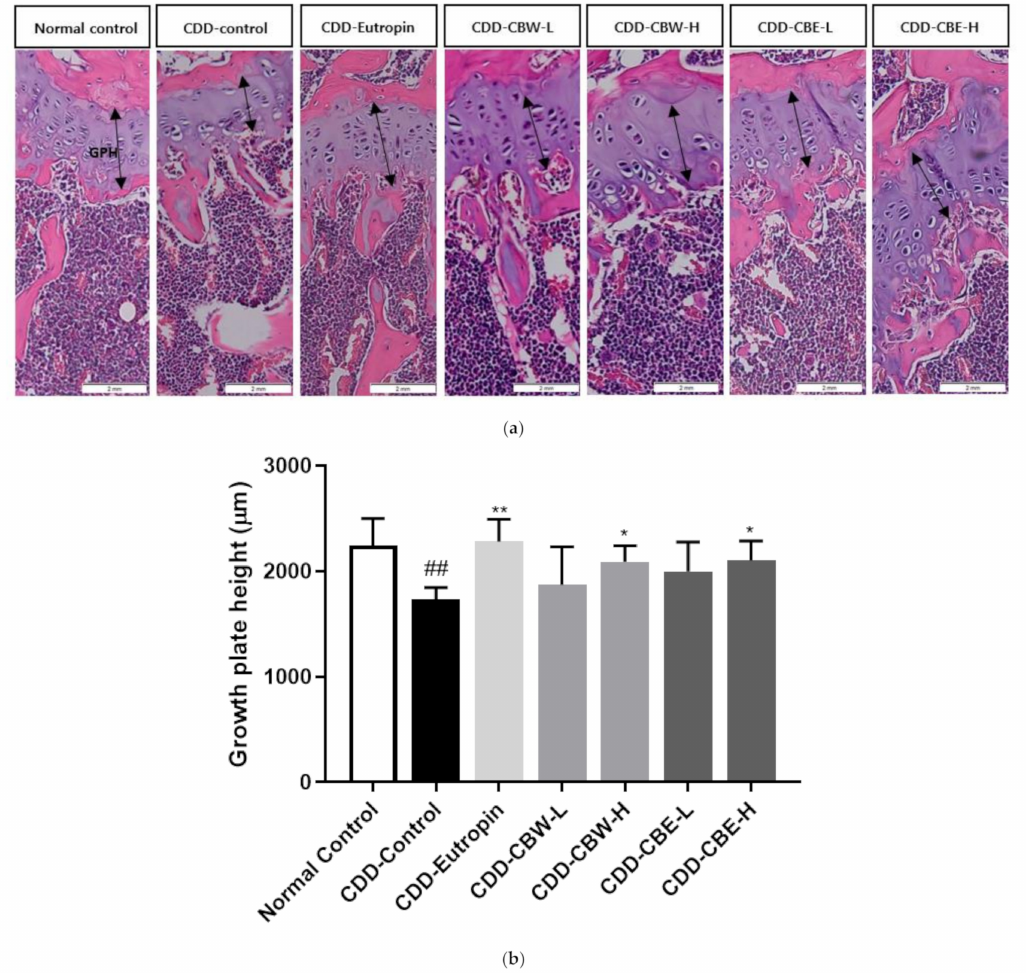
Figure 6. ( a ) Morphology of paraffin sections from CBW and CBE in tibial growth plates; magnification, 10X and ( b ) total growth plate height. The arrow indicates the growth plate height (GPH). All data are presented as the mean ± SD, and differences were compared by one-way ANOVA. ## p < 0.001 compared with the normal control group, * p < 0.05, and ** p < 0.01 compared with the CDD-control